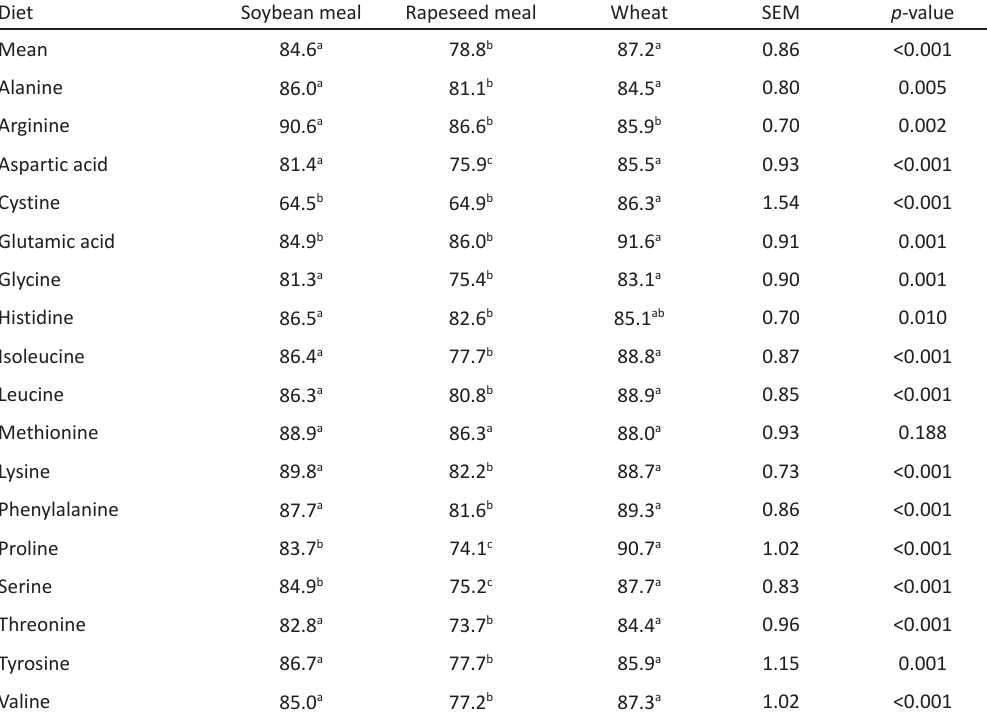
mean SID of amino acids in soybean meal and wheat were higher compared with rapeseed meal ( p <0.05) (Table 6). Lysine and threonine SID were higher in soybean meal and wheat compared to rapeseed meal ( p <0.05). Methionine SID was similar among ingredients ( p >0.05). Cystine SID was higher in wheat than in rapeseed meal and soybean meal ( p <0.05). Table 6. Standardised ileal digestibility of amino acids (%) in soybean meal, rapeseed meal and wheat measured with broilers (n=4 per treatment) Diet Soybean